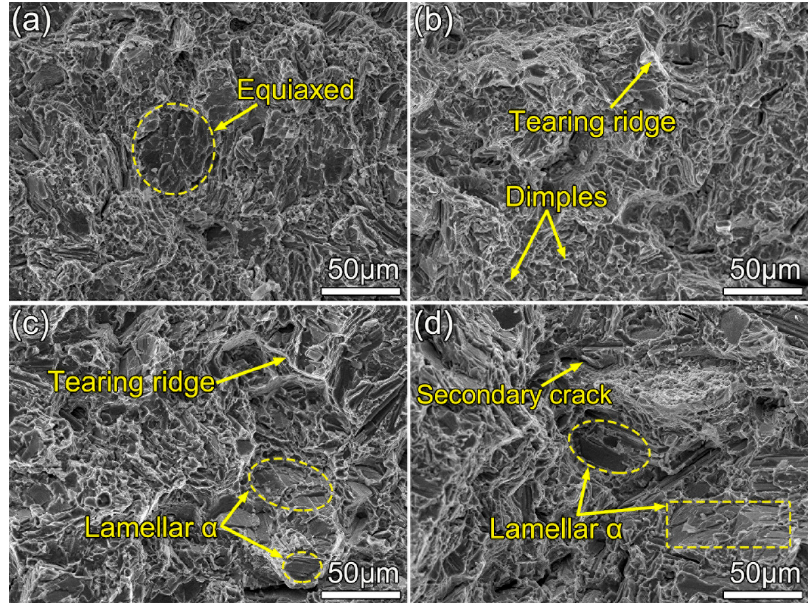
Figure 7. Representative fractographs of 7.5 vol.% TiB w /Ti composites under different conditions: ( a ) as-forged; ( b ) HT1; ( c ) HT2; and ( d ) HT3.